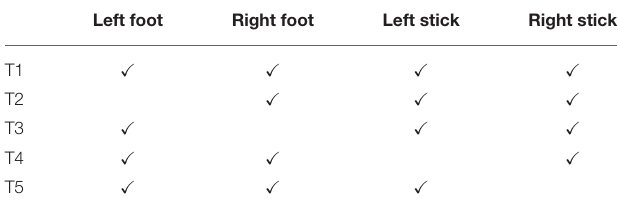
TABLE 1 | Five different combinations of contact